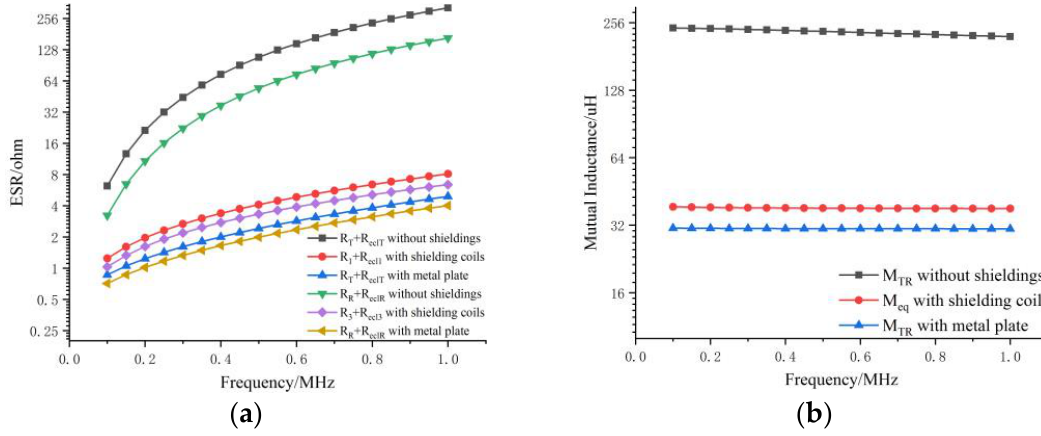
Figure 7. The relation between ESR of coils, the equivalent mutual inductance between coils and the work frequency. ( a ) ESR of coils change with frequency for three structure WPT system. ( b ) The mutual inductances change with frequency for three structure WPT system.